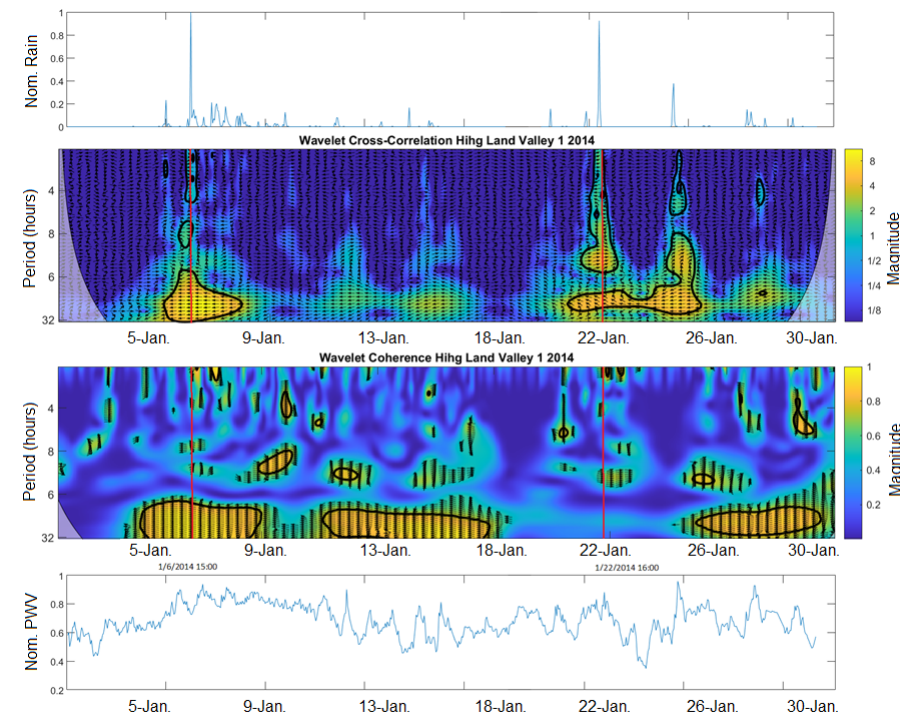
Figure 6. Zoom-in of the continuous wavelet cross-spectrum XWT and wavelet coherence scalogram WTC of the Andes Valley 1 (Quito) station for January 2014 compared with their normalized time series. Note the vertical red line which intersects the time domain for both plots and how there is coherence with a significance boundary of 5%, marked by the black line, for the 6 January event while there is none for the 22 January event.